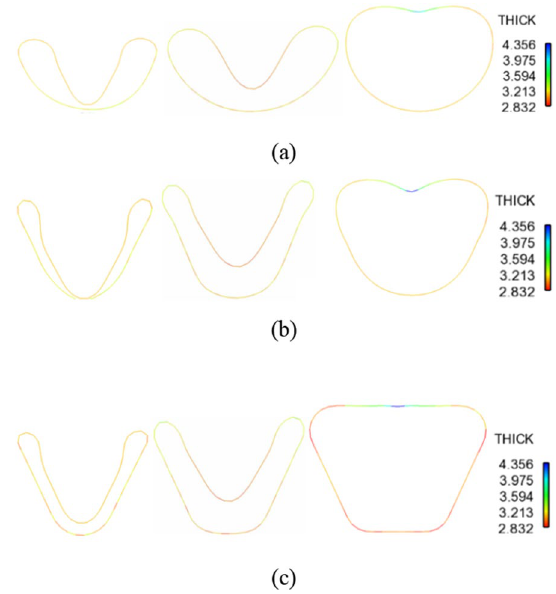
Figure 29 Cloud maps of the wall thickness of sections during torsion beam forming: ( a ) Cloud maps of the wall thickness of sections A–A, D–D, and F–F during the closing of the upper mold clamping, ( b ) Cloud maps of the wall thickness of sections A–A, D–D, and F–F during sliding mold clamping closing, ( c ) Cloud maps of the